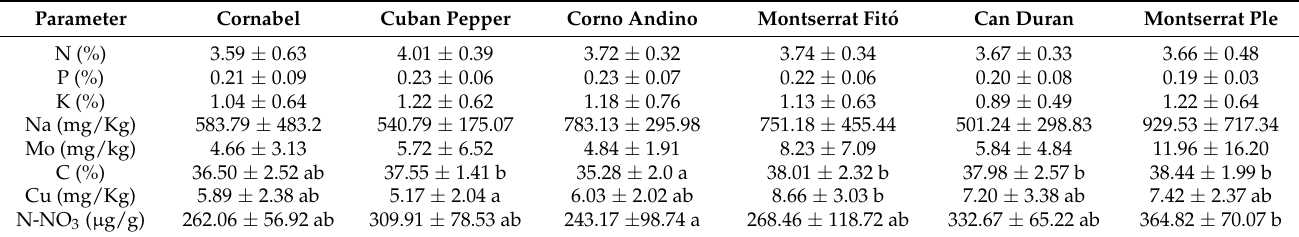
Table 6. Leaf mineral nutrients of tomato